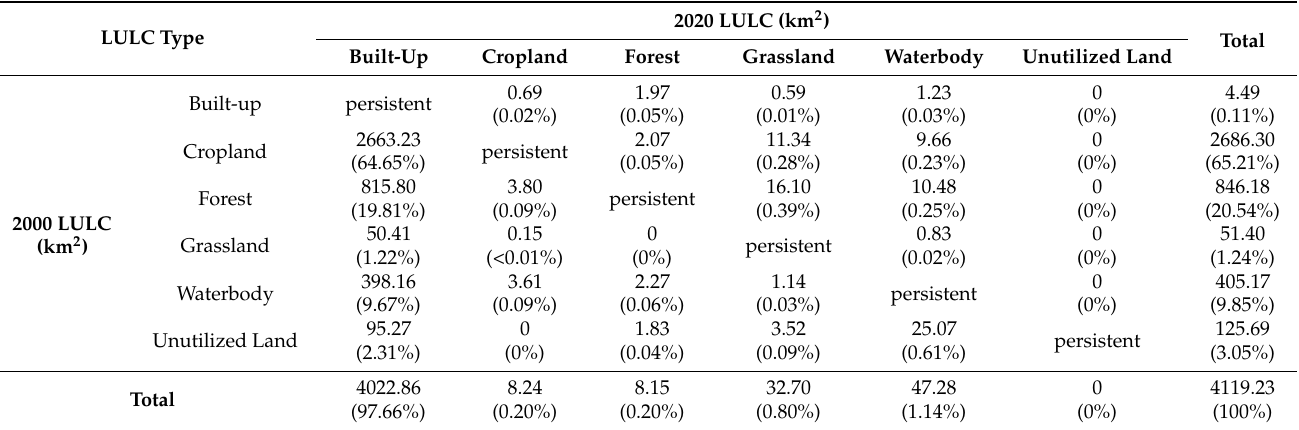
Table 1. Land use/land cover (LULC) transfer matrix in the GBA from 2000 to 2020. LULC